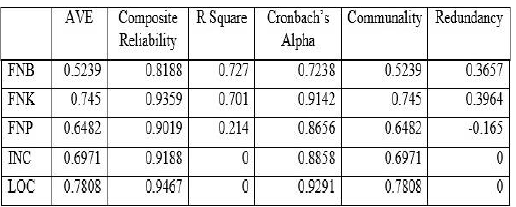
Table 4: The Reliability Measures